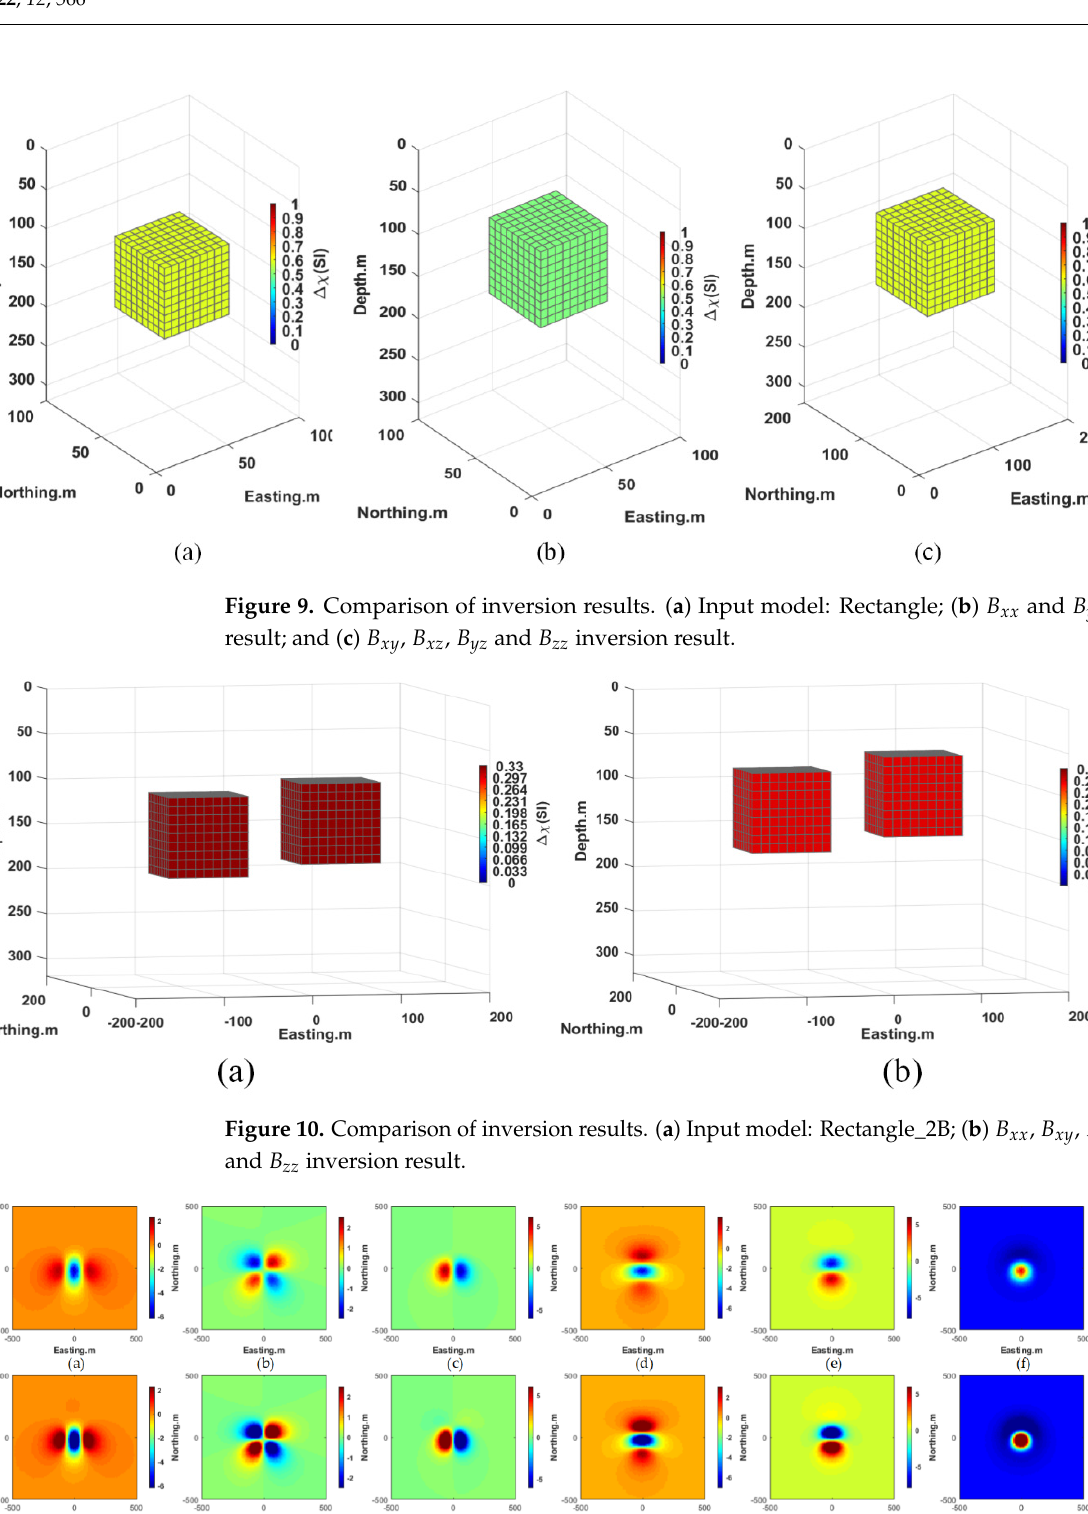
Figure 12. Comparison of the Rectangle_2B model’s components and prediction model’s compo- nents. ( a – f ) are the